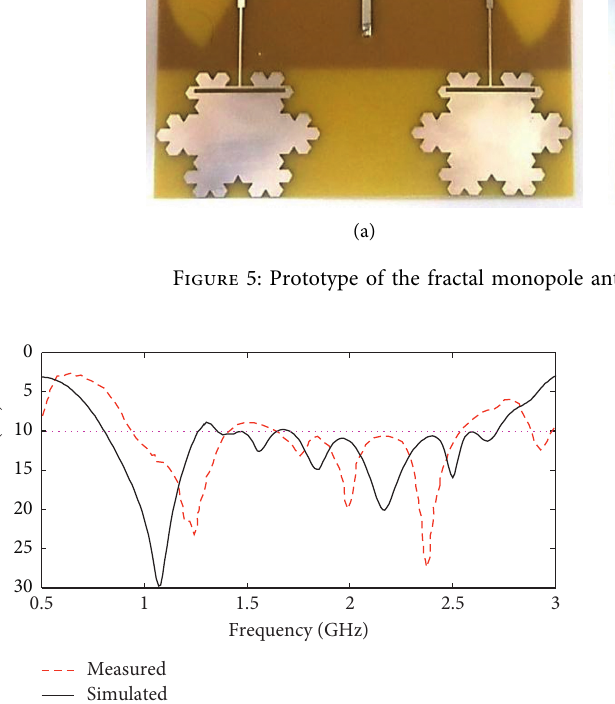
Figure 6: Simulated and measured return loss of the proposed antenna array.